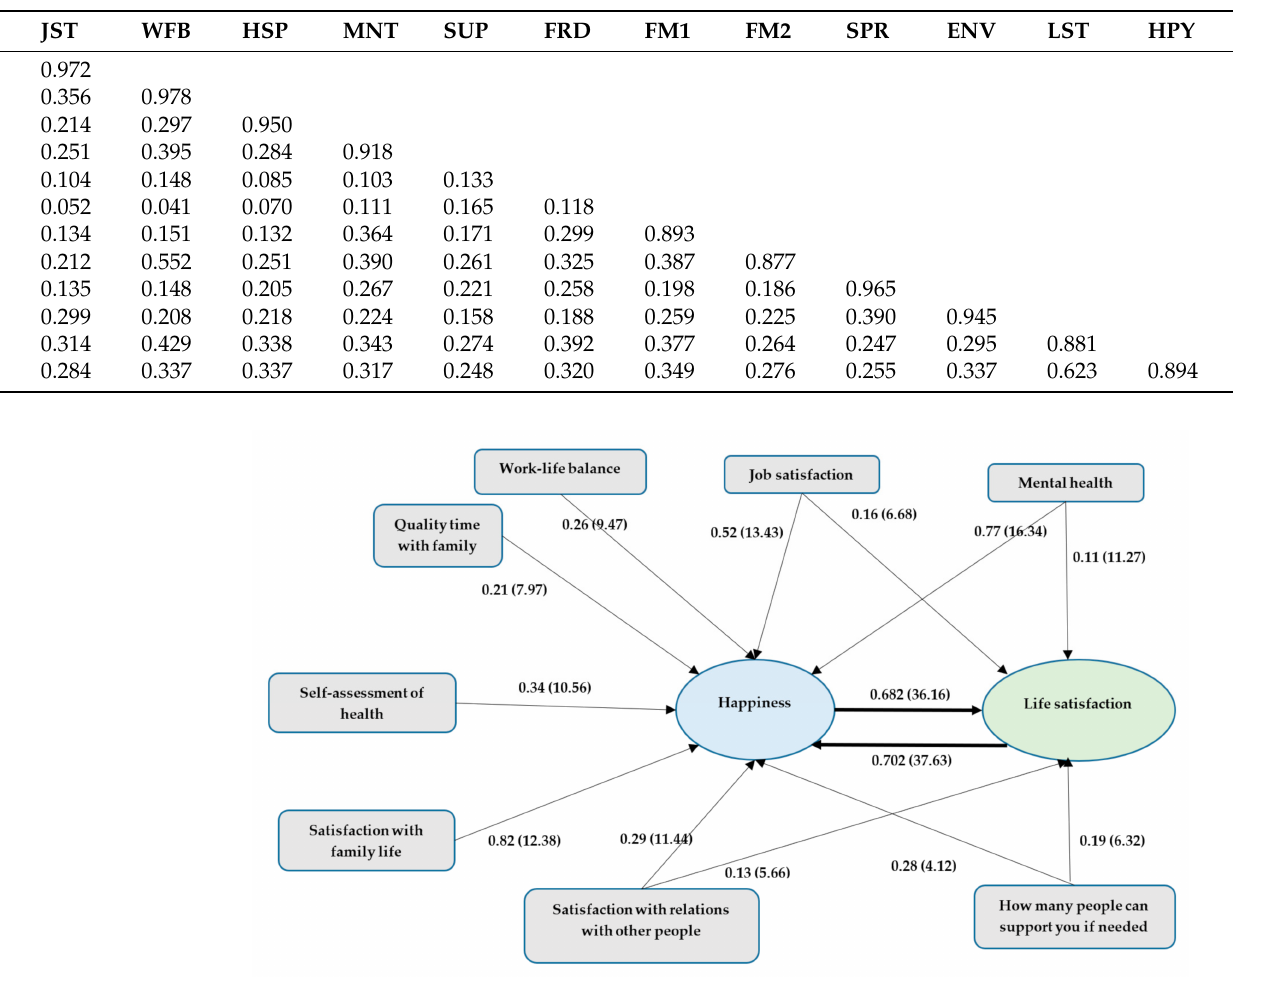
Figure 1. The path analysis model (estimate and t -value). Table 5. Goodness of fit statistics for the final